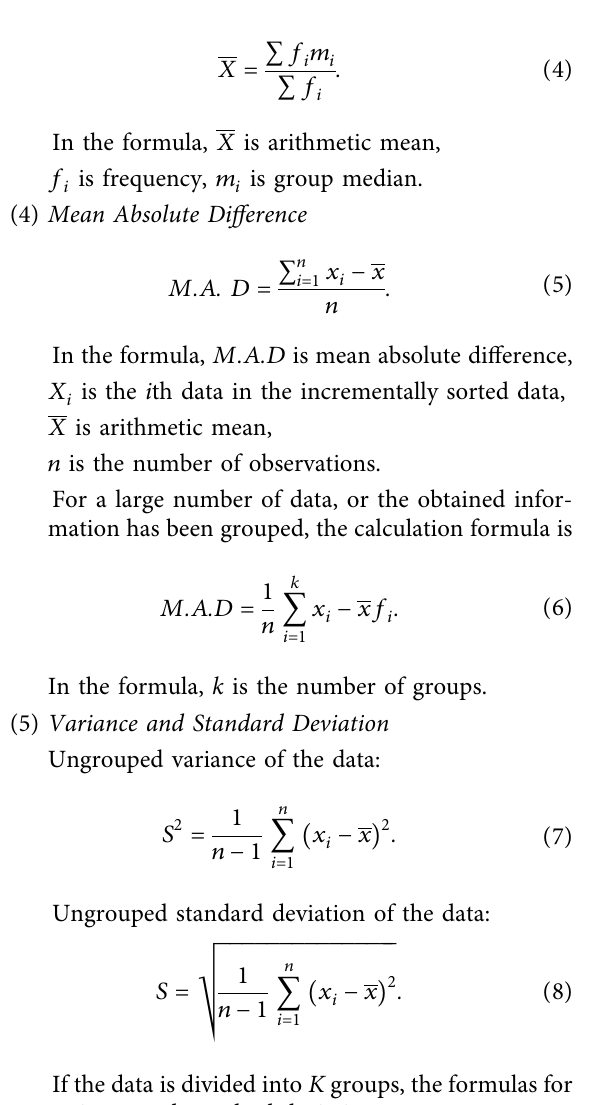
Figure 4: P2P and centralized network mode. (a) P2P network model. (b) Centralized network